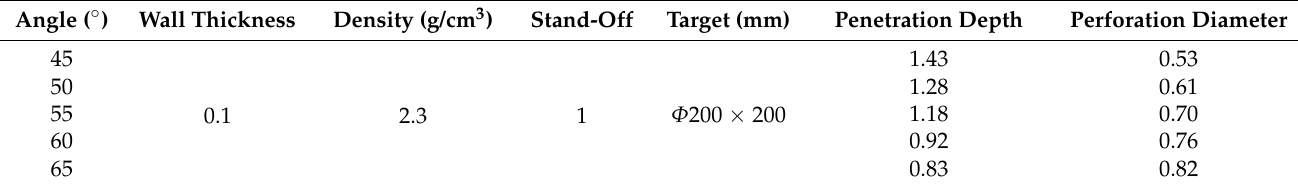
Figure 12. Experimental images of the shaped charge with different cone angles acting on a steel target. Table 2. Experimental results for reactive liner types with different cone angles